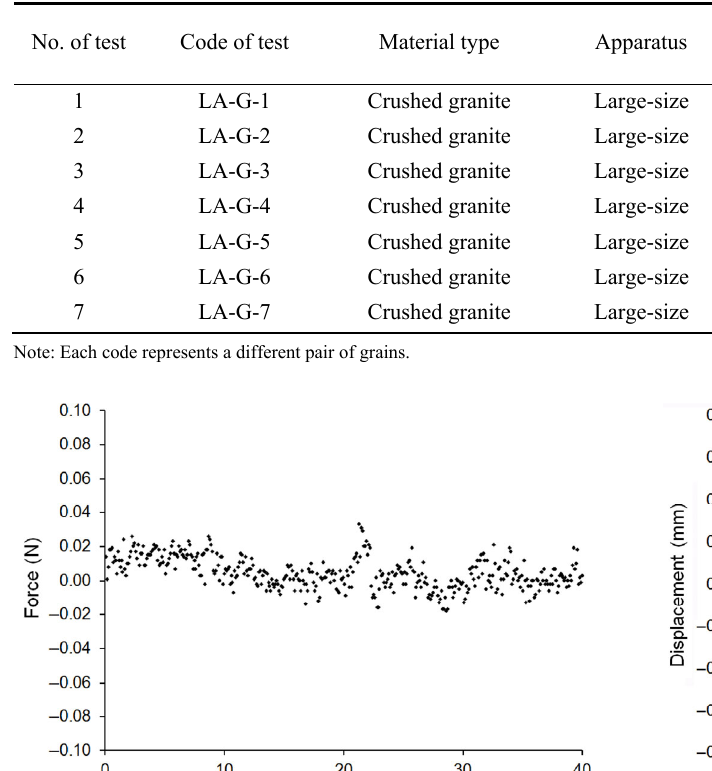
Note: Each code represents a different pair of grains. Table 2 Inter-particle sliding tests on natural granite